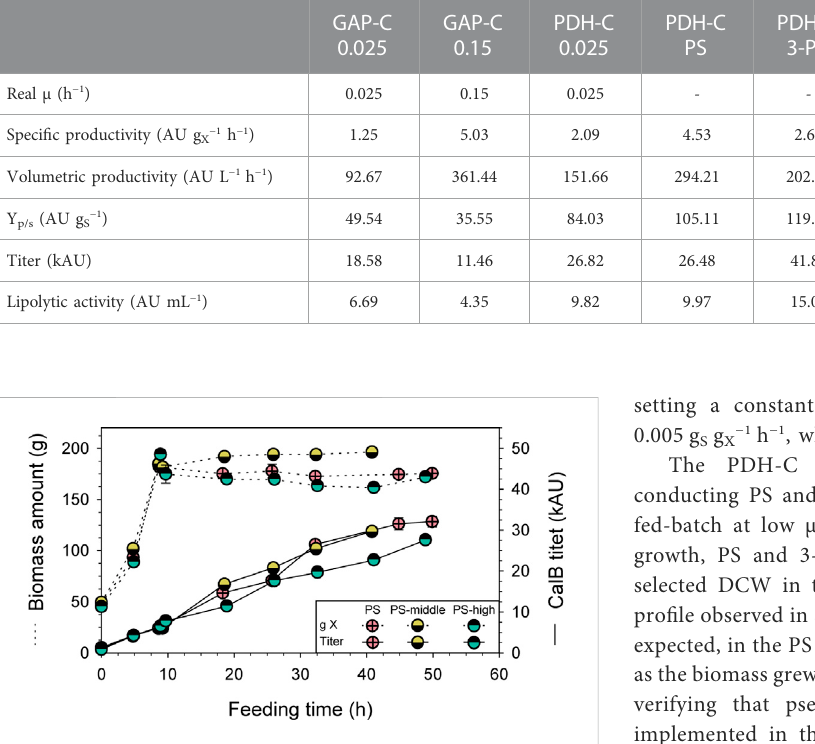
FIGURE 6 Optimization of PDH-C fed-batch cultivations through osmotic shock compared to the benchmark cultivation of PDH-C PS. Biomass and CalB titer evolution over time are represented of PDH-C cultivations at high, middle and low (PS) osmolarity. The errors bars represent the standard deviation of the